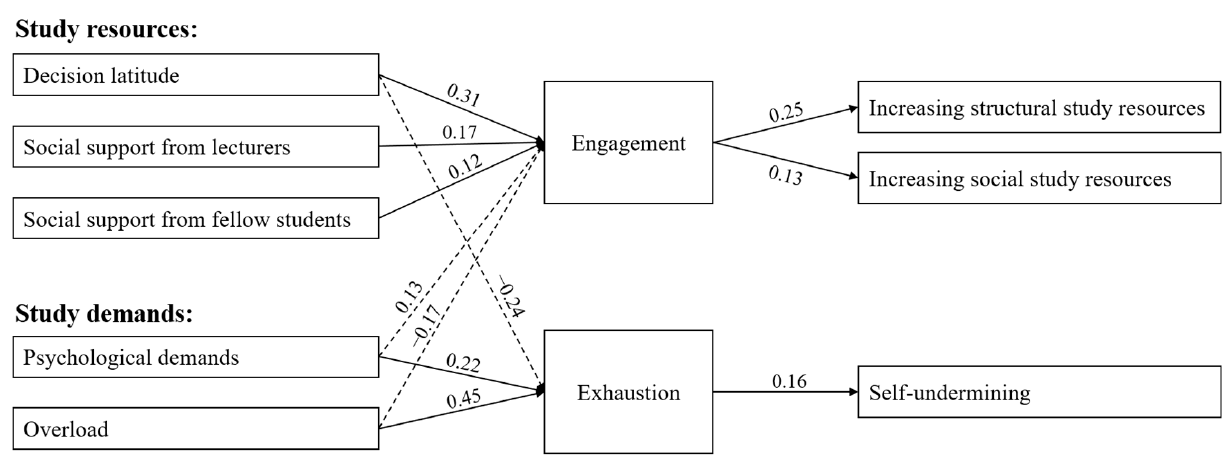
Figure 2. Within-person path coefficients. For ease of representation, direct effects from the predictors to the outcomes are not shown.